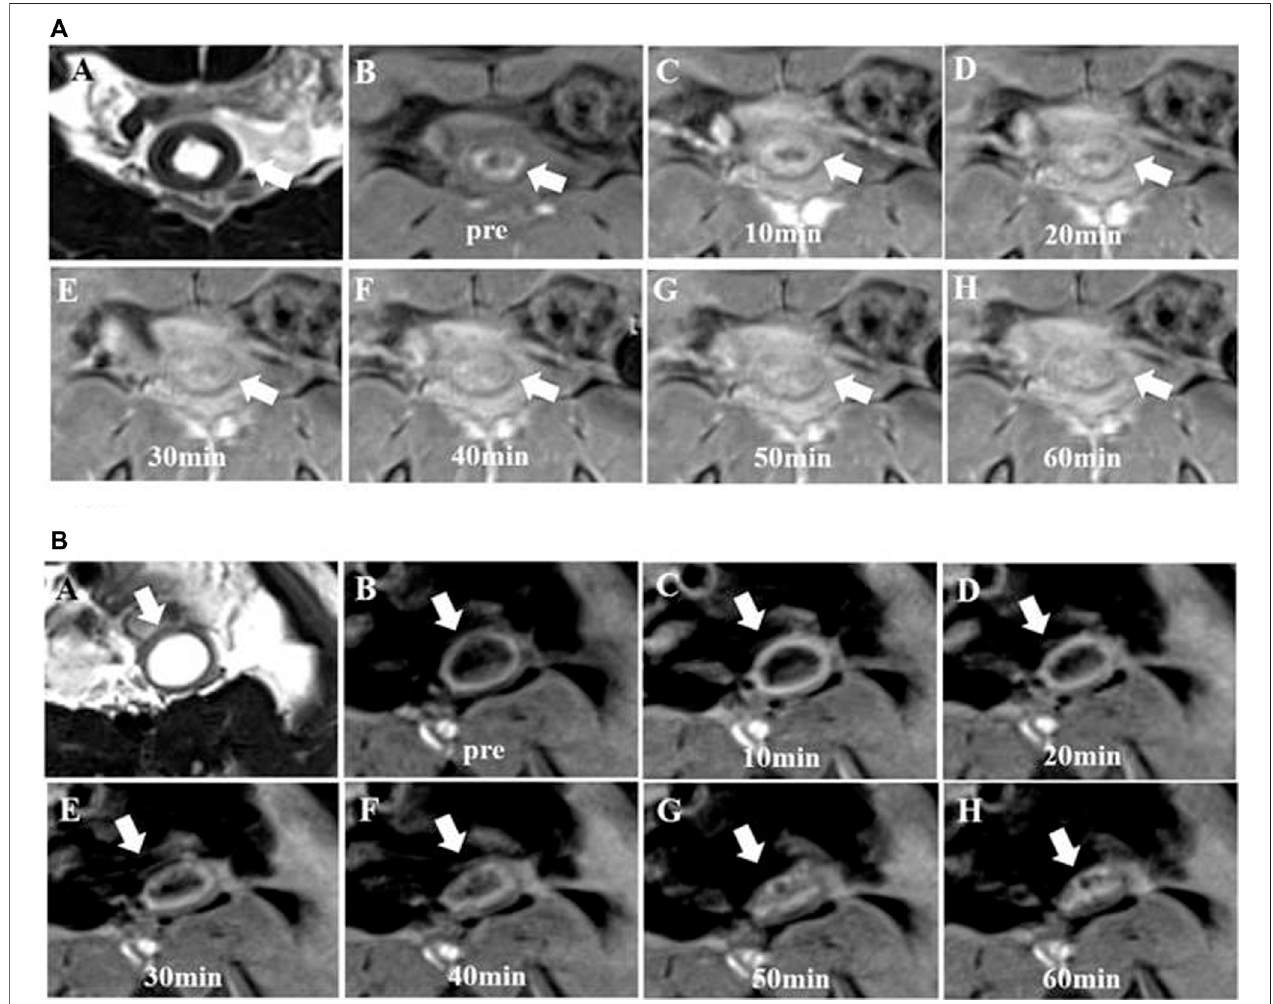
FIGURE 5 | Signal intensity maps of the fi brotic bowel wall obtained from MR imaging. A to H are maps of moderate bowel wall fi brosis. (A) , T2-weighted imaging enhanced from EP-3533 enhanced MR imaging: T2-weighted imaging (A) and T1-weighted imaging (B) showed thickening of the bowel wall. The mucosa of the bowel wall showed hyperintensity on T1-weighted imaging due to the mucus adhering to the bowel wall surface. After EP-3533 injection, the bowel wall fi brosis marked by the red arrows showedobviousenhancement (C – G) . (B) ,T2-weight imagingfromGd-DTPA enhanced MRimaging:AtoGarethemapsoftheothermoderate bowel wall fi brosis pre- and post-injection of Gd-DTPA. After Gd-DTPA administration, the bowel wall fi brosis showed slight enhancement.